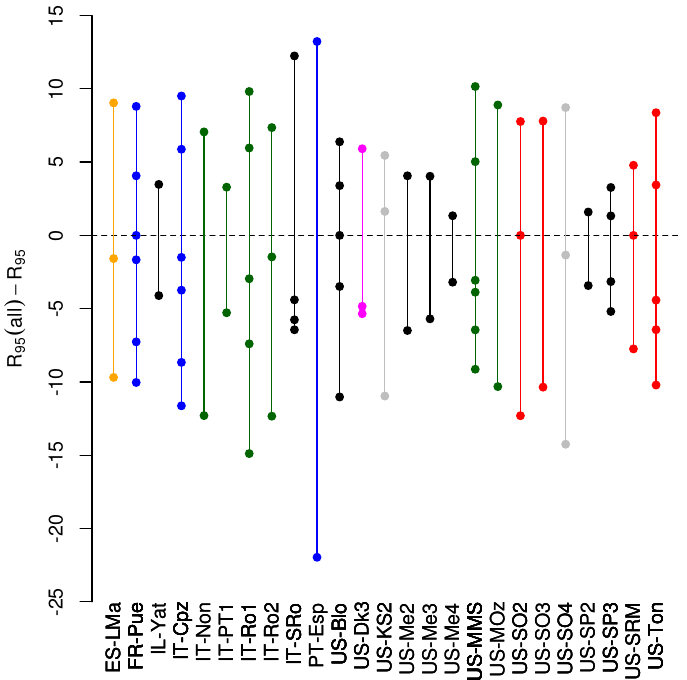
Fig. 1. Differences between R 95 statistics calculated based on a daily rainfall distribution derived from all precipitation data available for each site and R 95 values calculated for each site year separately. Points show values for individual site-years; vertical lines highlight the range of differences for each site. Sites are colour-coded by the IGBP ecosystem type: grey – CSH, green – DBF, blue – EBF, black – ENF, magenta – MF, orange – SAV, red –